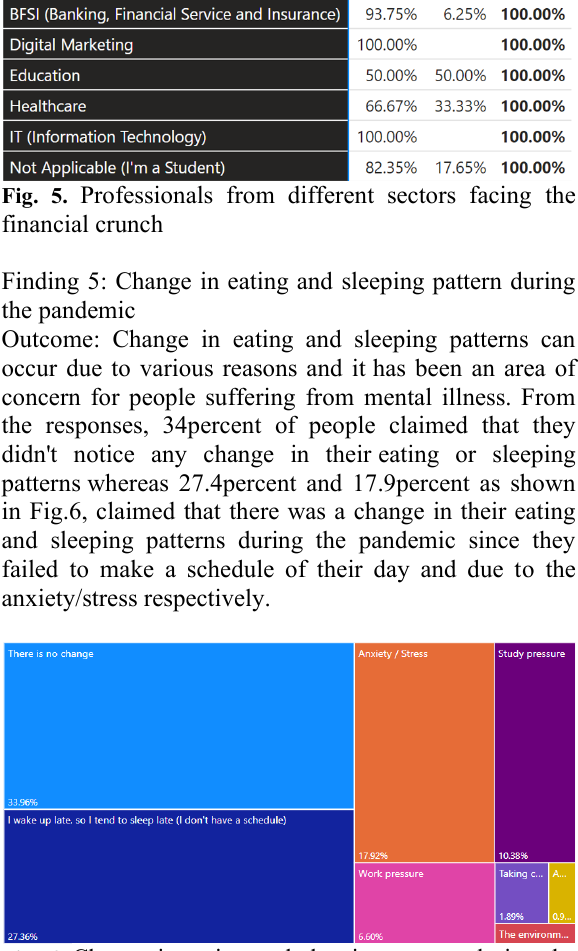
Fig. 6. Change in eating and sleeping pattern during the pandemic